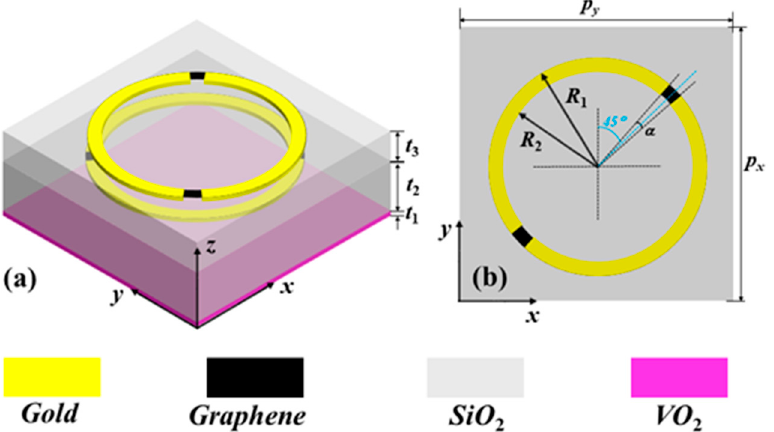
Figure 1. Proposed metamaterial structure: ( a ) three-dimensional schematic and ( b ) top view.